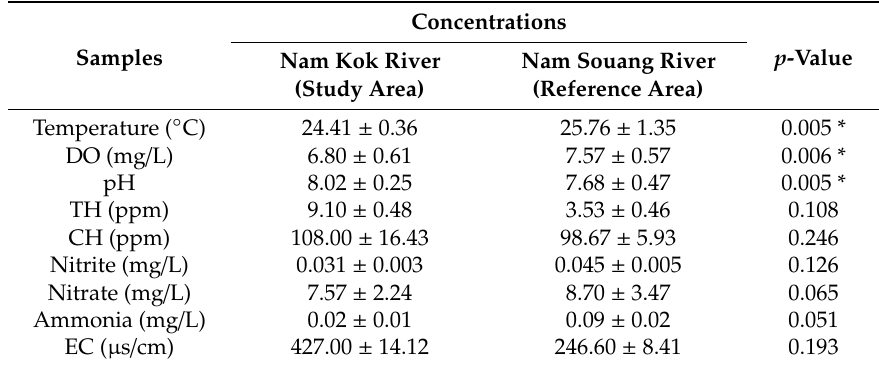
Table 2. The water quality parameters of the Nam Kok river near the Sepon gold-copper mine as the study area and the Nam Souang river as the reference